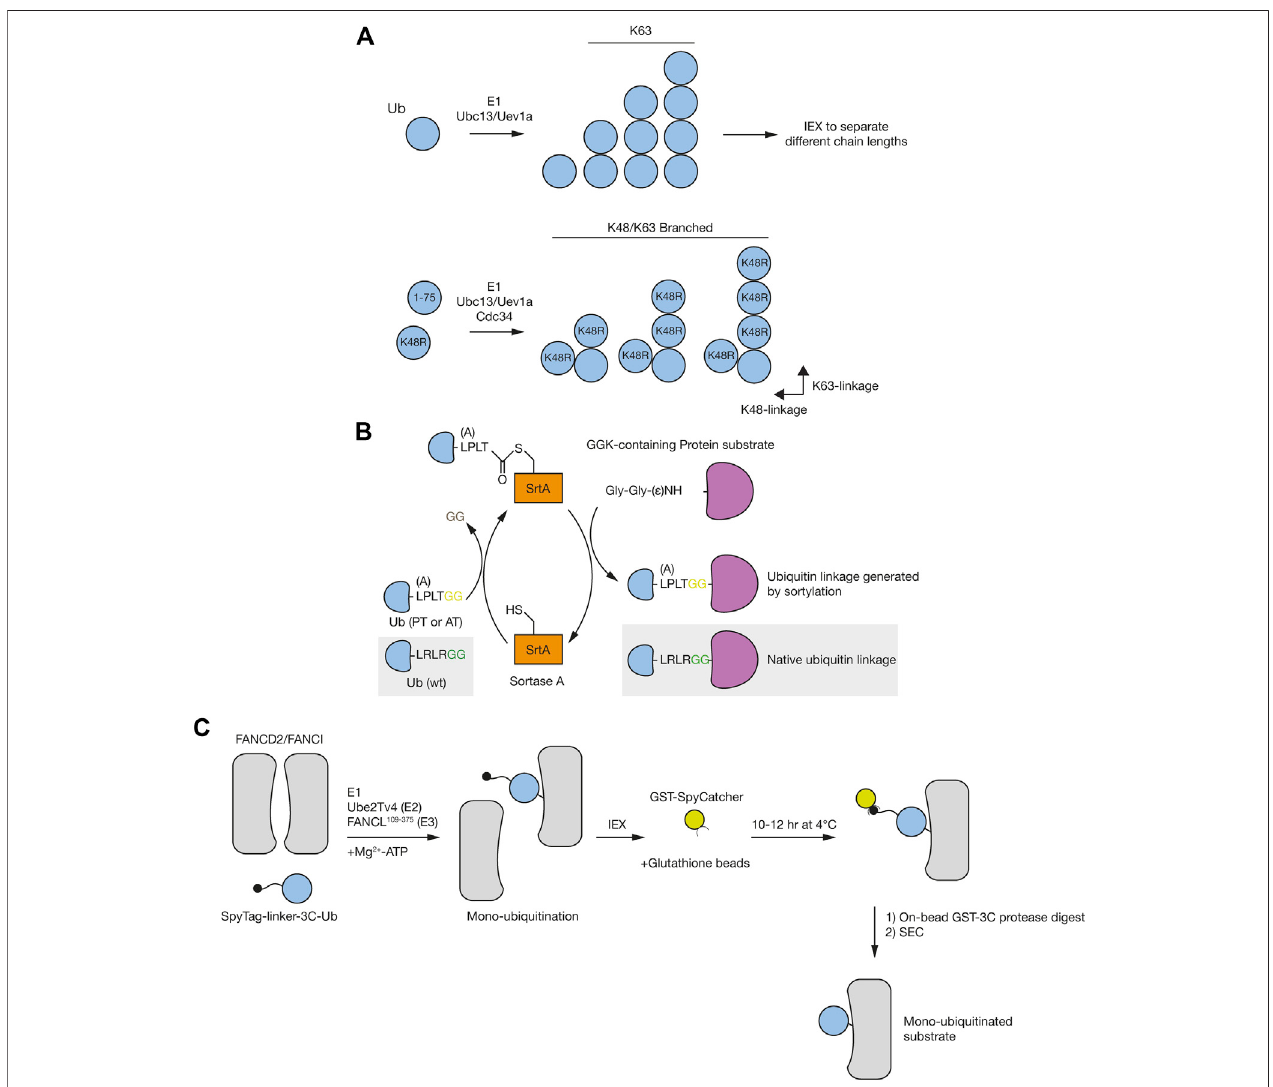
FIGURE 5 | Preparation of designer substrates to investigate the DDR and ubiquitin signaling. (A) Using E2 conjugating enzymes and speci fi c E3 ligases and/or DUBs enablesthe formation de fi ned ubiquitin chain types. Ubiquitin chains of different lengths can be separated by ion-exchangechromatography (IEX). Use ofspeci fi c ubiquitin mutants enables the formation of branched or more complex species. (B) A GGK-containing protein can be prepared by site-speci fi c incorporation of the unnatural amino acid AzGGK using genetic-code expansion. In vivo Staudinger reduction converts AzGGK to GGK, which can undergo transpeptidation with a ubiquitinmutantcontainingasortaserecognitionmotif(LPLTGorLALTG)viaSrtA.TheresultingubiquitinatedproteindisplaysanativeisopeptidebondwithR72P/R72A and R74Tpointmutationsinthelinker region. (C) Useofengineered E2and E3enzymeswithtagged ubiquitinenablestheef fi cient formationofspeci fi callyubiquitinated substrates. Subsequent steps such as IEX, af fi nity puri fi cation and size-exclusion chromatography (SEC) enable enrichment of the uniformly ubiquitinated species.